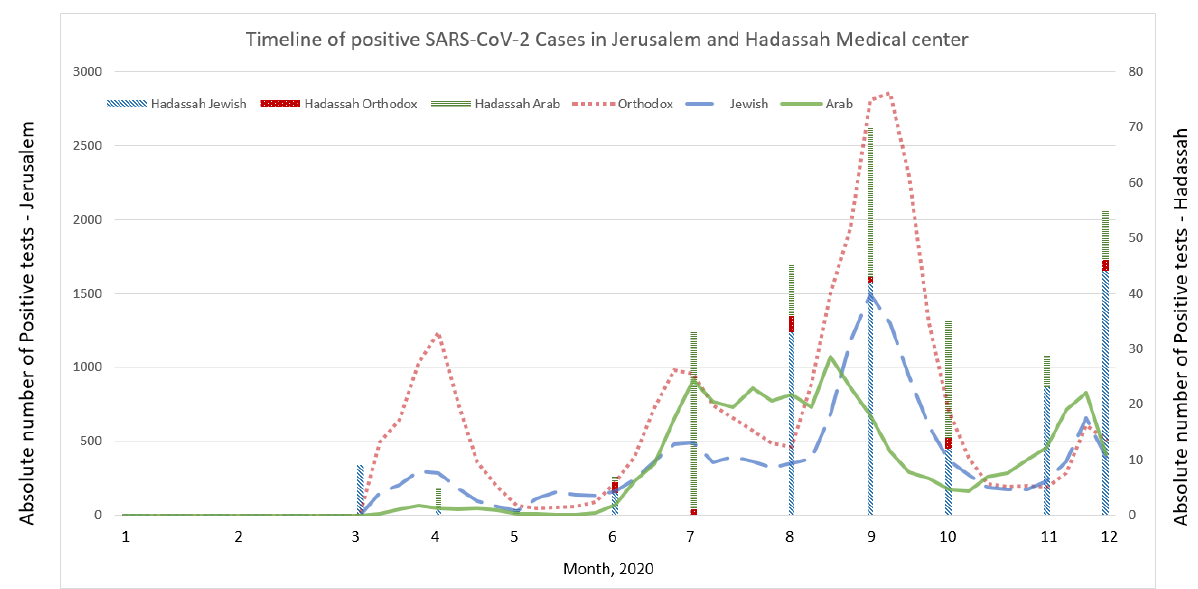
Figure 2. Absolute number of SARS-CoV-2-positive tests over 2020 in Jerusalem and Hadassah medical center. Colored lines represent the Jerusalem population, and stacked columns represent the Hadassah hospital group.